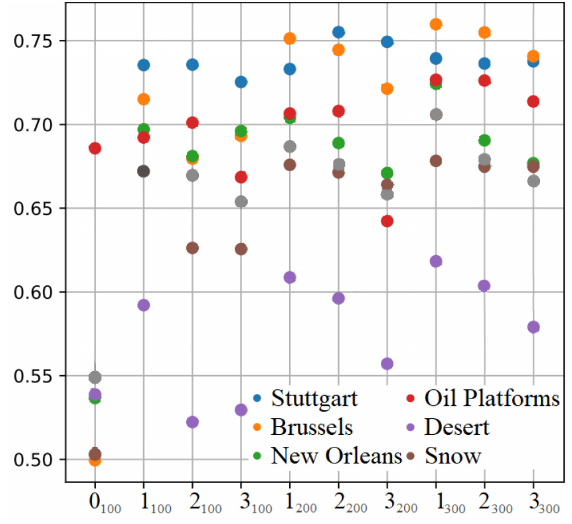
Figure 8. BA for all test sites (grey) and single test sites; number i n indicates n training scenes of training sites ( i ) are considered in equal